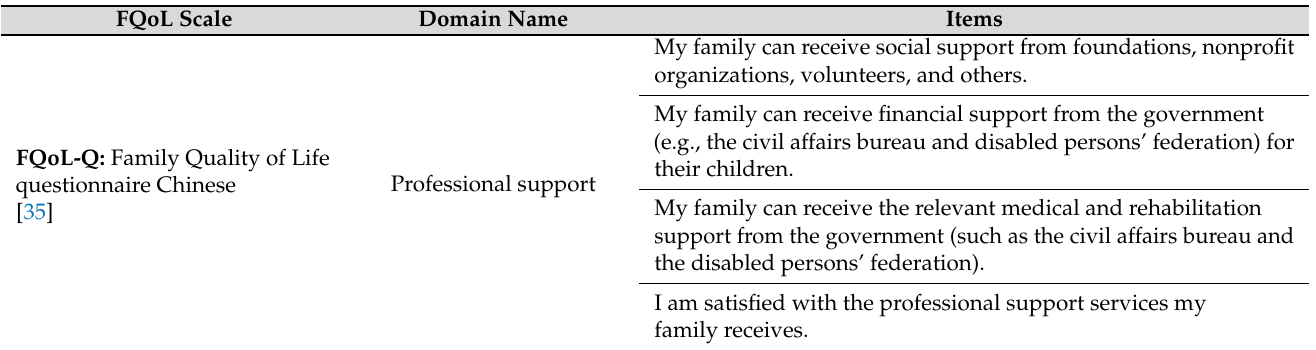
Table 8. Items considered in the domain of professional support within each FQoL